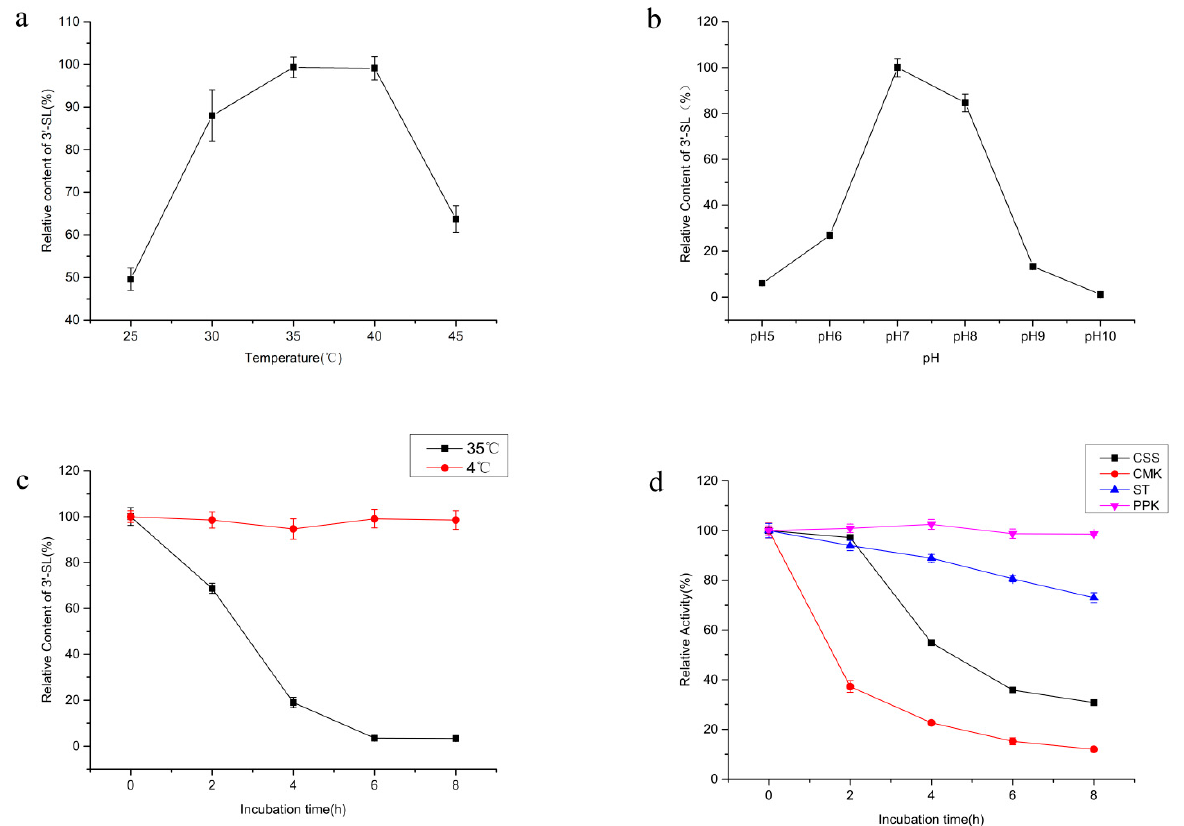
Figure 3. Effect of temperature and pH on the conversion. ( a ) Effect of temperature on the conversion; ( b ) effect of pH on the conversion; ( c ) catalytic stability under different temperatures; ( d ) stability of enzyme activity under optimal temper- ature.